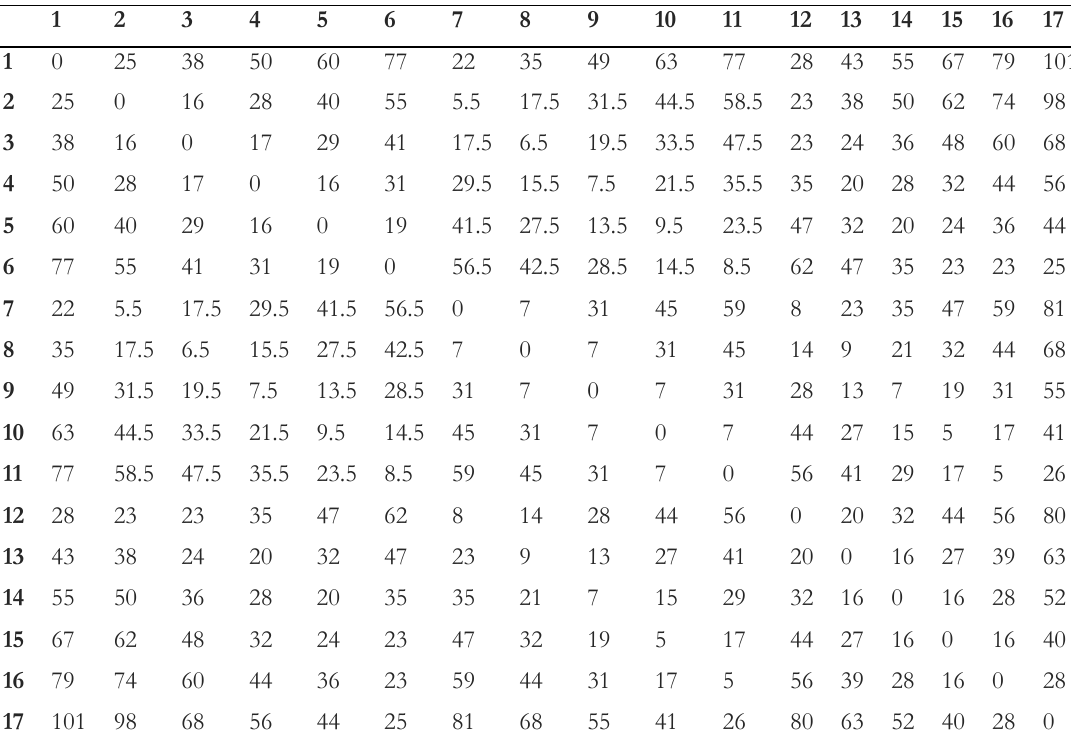
Table 1. Distance of locations (meter).